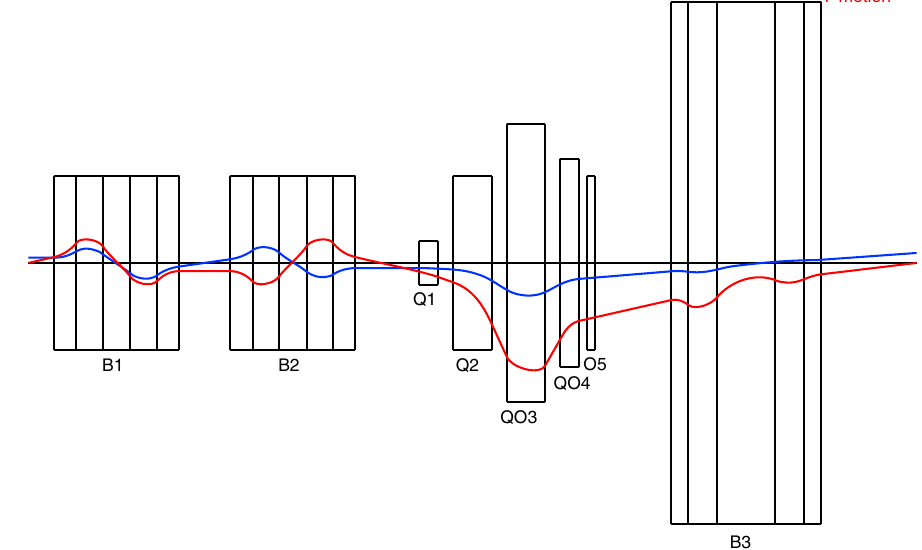
FIG. 5. Principle out-of-plane rays for the full system [initial rays are y ¼ 3 mm (blue), and p y ¼ 10 mrad (red)]. The full width of B1, B2, and B3 are 10, 10, and 30 cm, respectively.